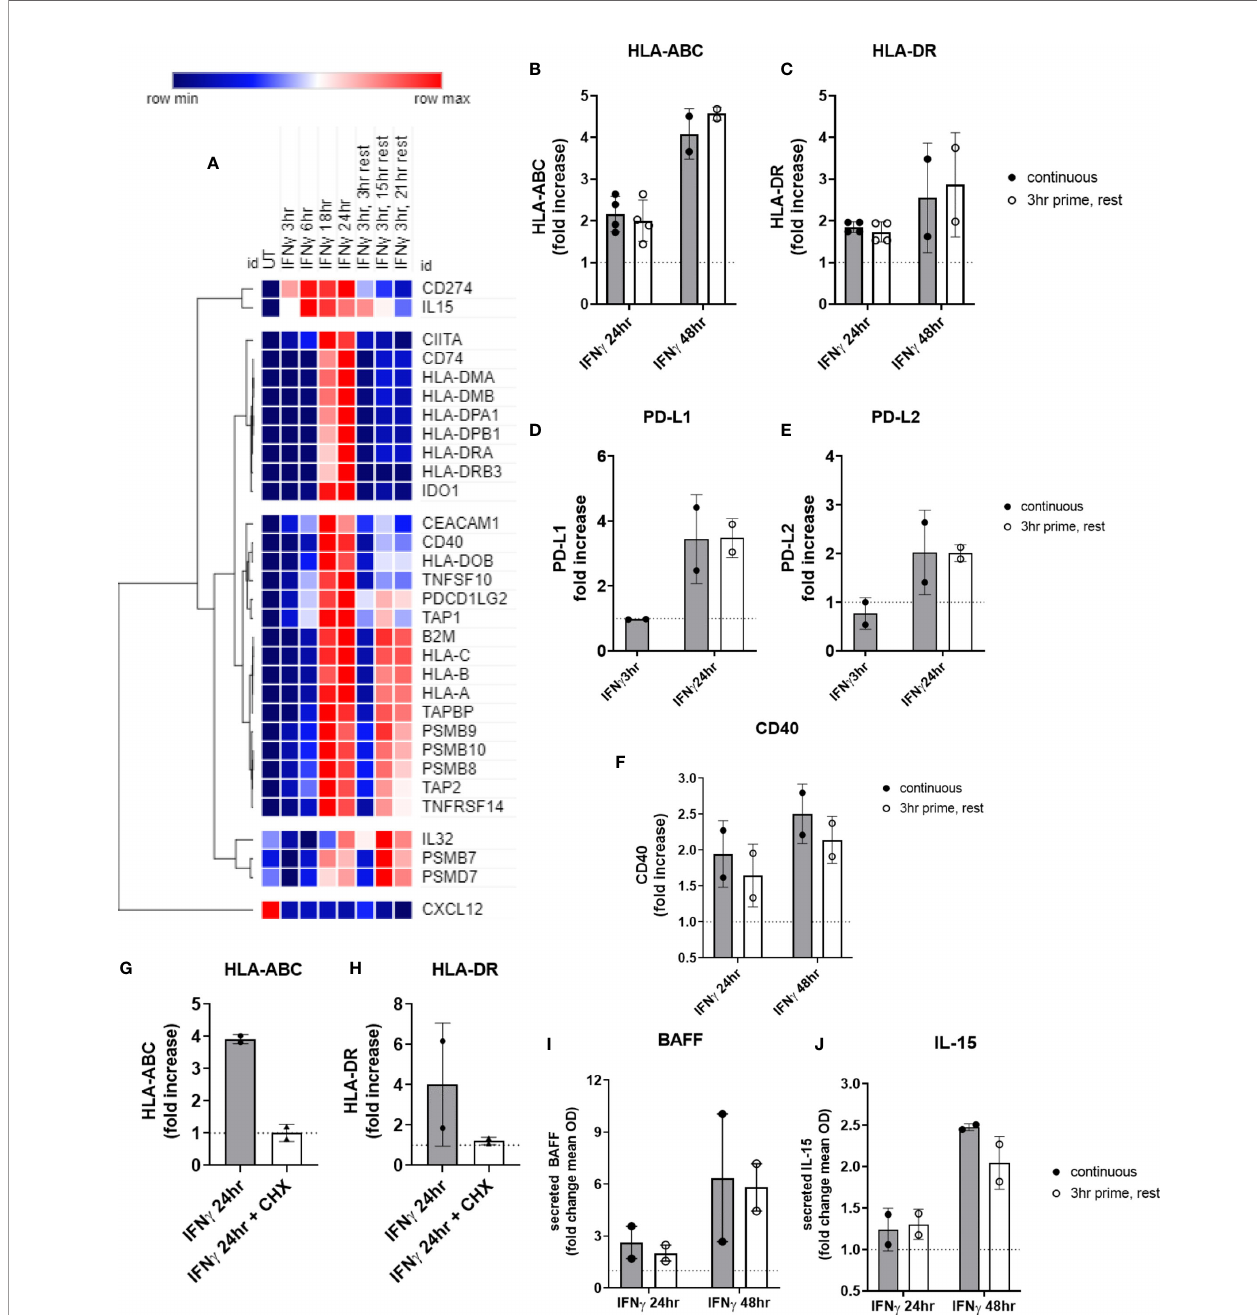
FIGURE 11 | Short priming with IFN g followed by withdrawal/rest in the absence of cytokine. (A) HMEC-1 endothelial cells were treated with IFN g (200U/mL) for 3hr, 6hr, 18hr, or 24hr. In some conditions, medium was replaced after 3hr with medium without IFN g , and cells were allowed to rest for an additional 3hr, 15hr or 21hr. mRNA counts were measured by Nanostring and normalized to housekeeping genes and controls. Heat map shows relative gene expression over time, with normalization across genes/rows. Hierarchical clustering of rows by one minus pearson correlation. (B – F) Primary human aortic endothelial cells (n=2 donors) were treated with IFN g for 24hr or 48hr; or primed with IFN g for 3hr followed by an additional 21hr or 45hr without cytokine. Cell surface expression of (B) HLA-ABC, (C) HLA-DR, (D) PD-L1, (E) PD-L2 and (F) CD40 was measured by fl ow cytometry (n=2). Quantitated results are presented as average fold increase in MFI of each molecule relative to untreated cells (C) . * (G, H) Primary human aortic endothelial cells (n=2 donors) were treated with IFN g for 24hr (black bars); or pulsed with IFN g for 3hr followed by an additional 21hr in plain medium (grey bars) or medium with cycloheximide (CHX, white bars). Cell surface expression of (G) HLA-ABC and (H) HLA-DR was measured by fl ow cytometry. (I, J) Primary human aortic endothelial cells were treated with IFN g for 24hr or 48hr (black bars); or primed with IFN g for 3hr followed by an additional 21hr or 45hr without cytokine (white bars). Conditioned medium was assayed for secreted (I) BAFF or (J) IL-15 protein by ELISA. Results are expressed as average fold increase in concentration in the supernatant +/-SEM